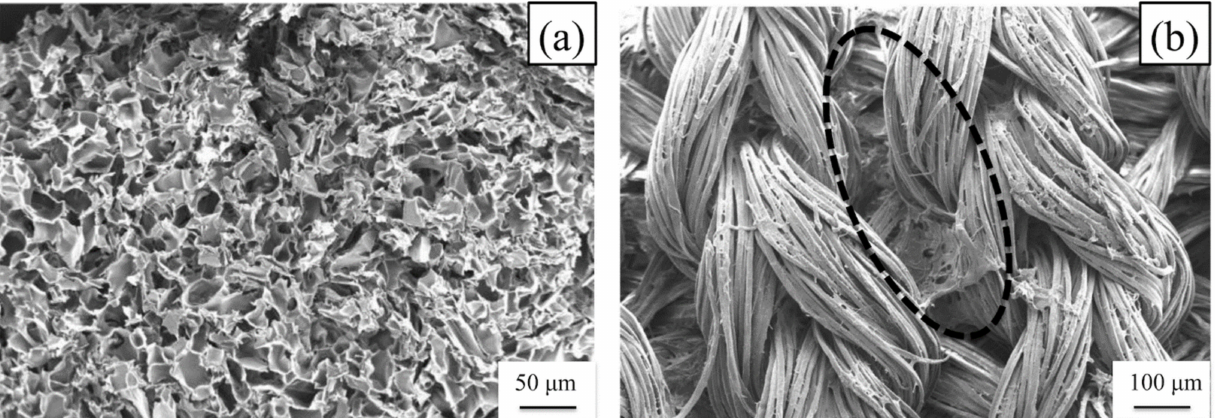
Figure 7. Scanning electron microscopy pictures of ( a ) PU-SF composite sponge and ( b ) outer surface of double-raschel knitted SF vascular grafts coated with PU-SF composite sponge before implantation. The part enclosed by the dotted line shows the PU-SF composite